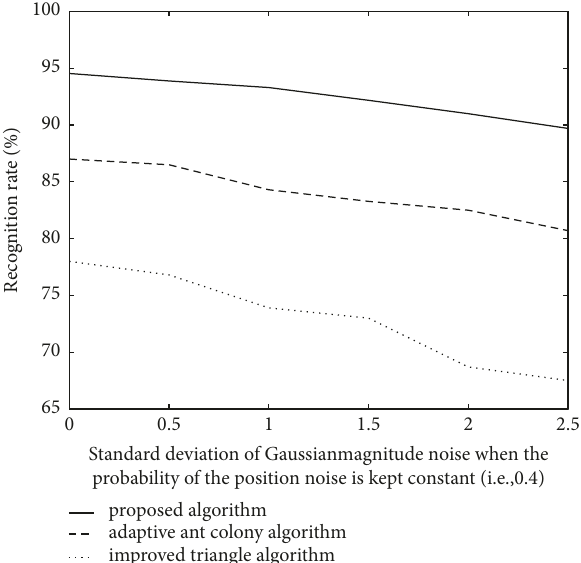
Figure 4: Recognition results under position noise.